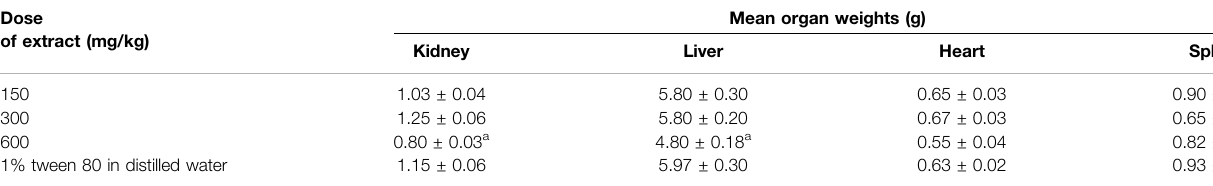
TABLE 5 | Mean weight of vital organs after 28 days at different doses of the extracts. Dose of extract (mg/kg)